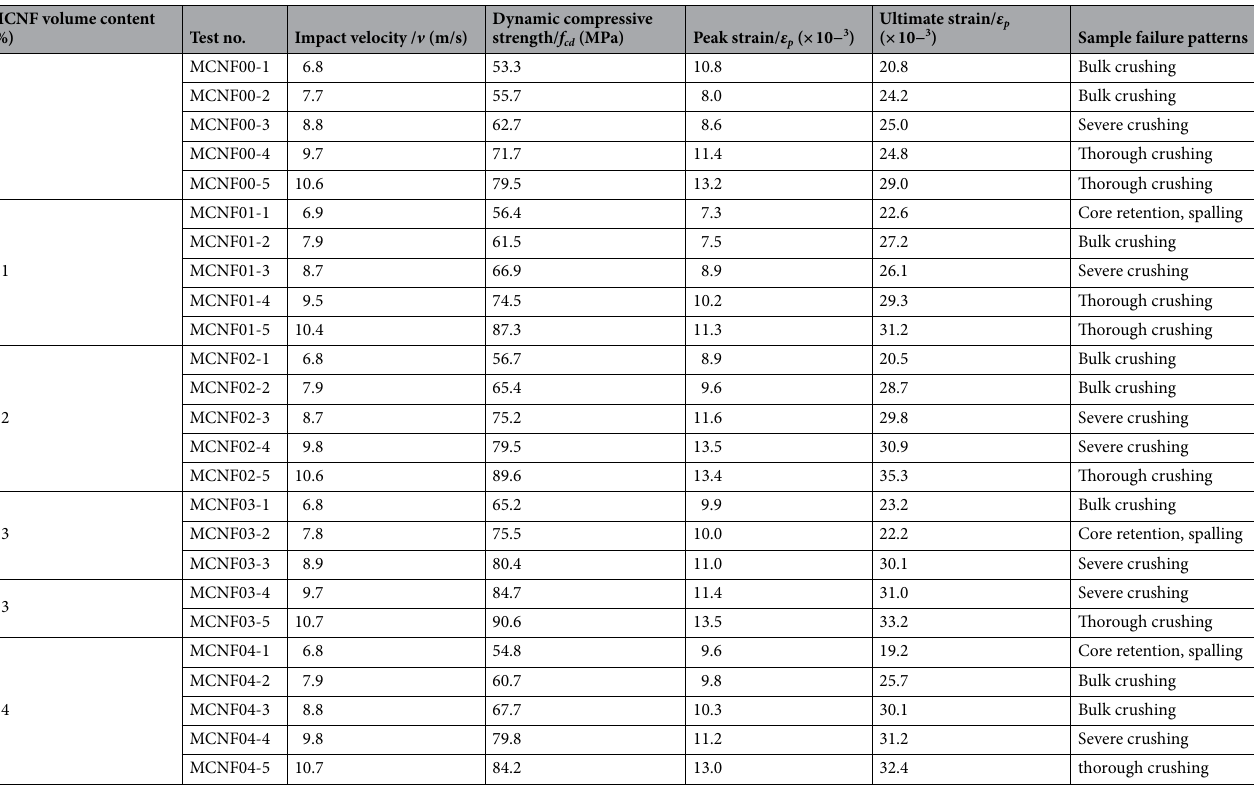
Table 6. SHPB Results of MCNF